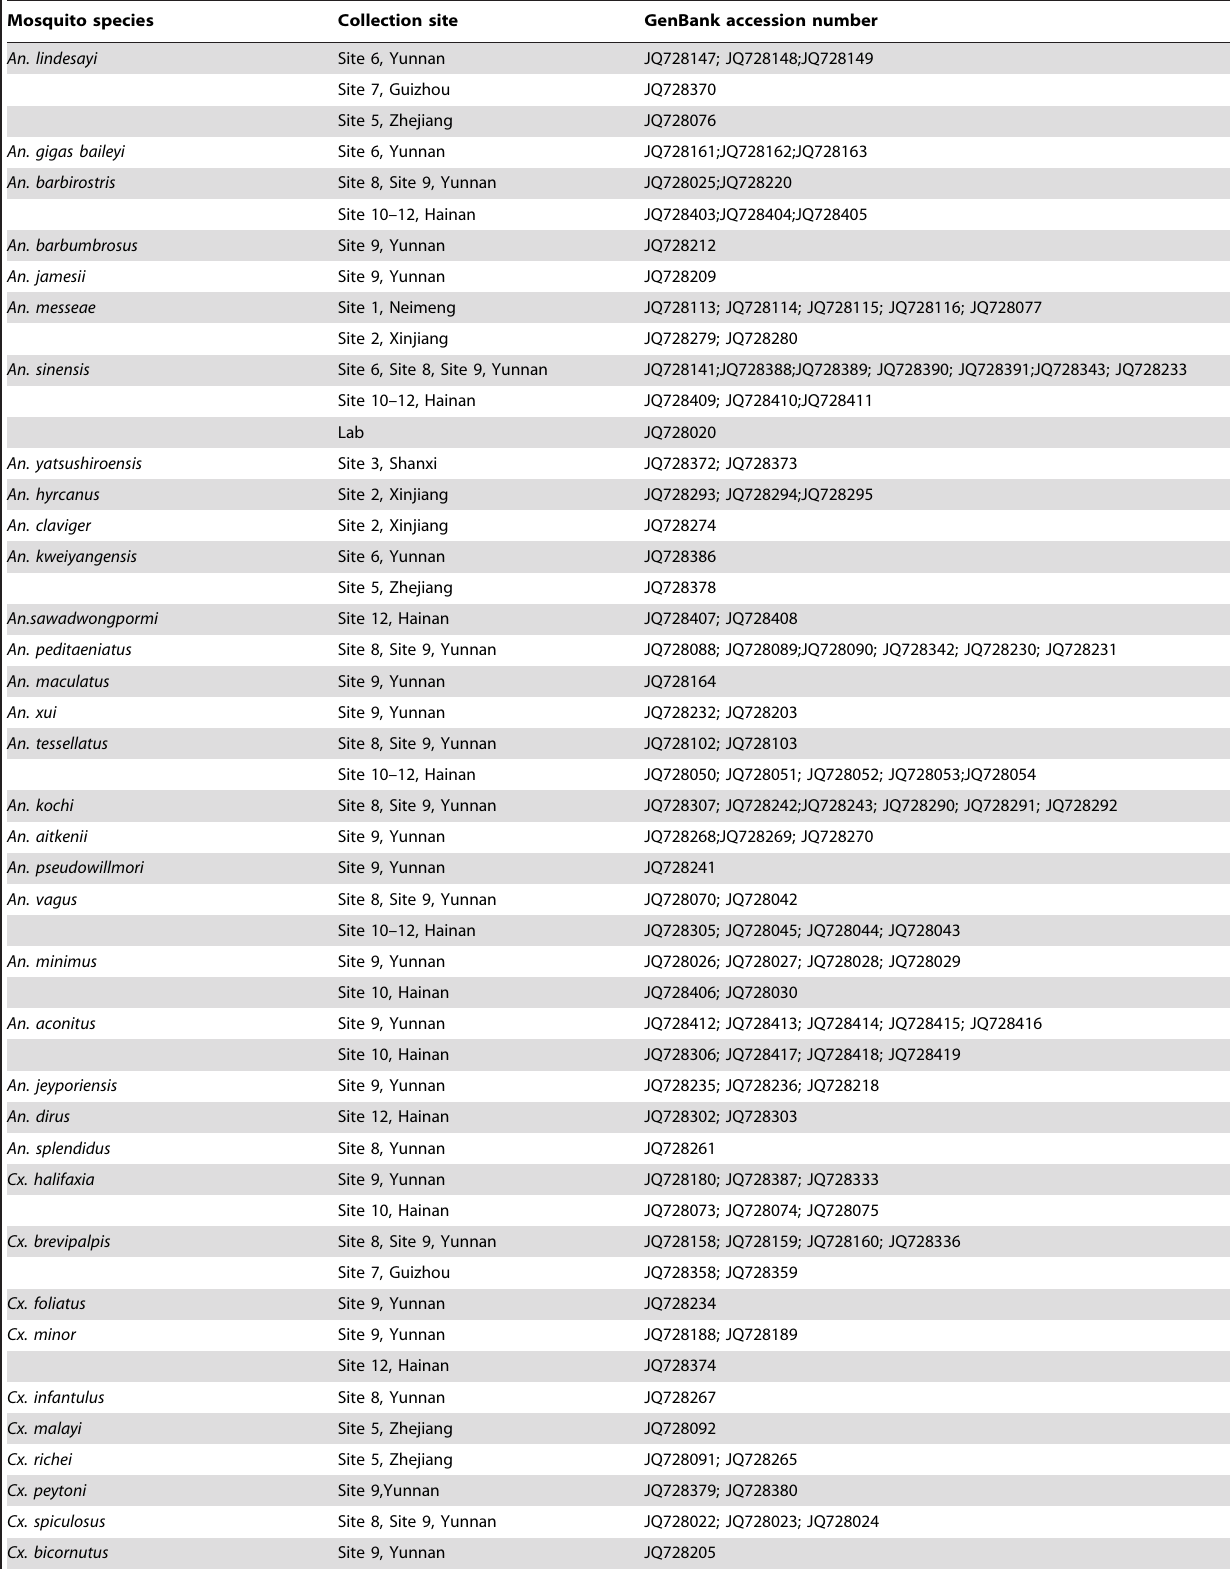
Table 1. List of mosquito species, collection sites and GenBank accession